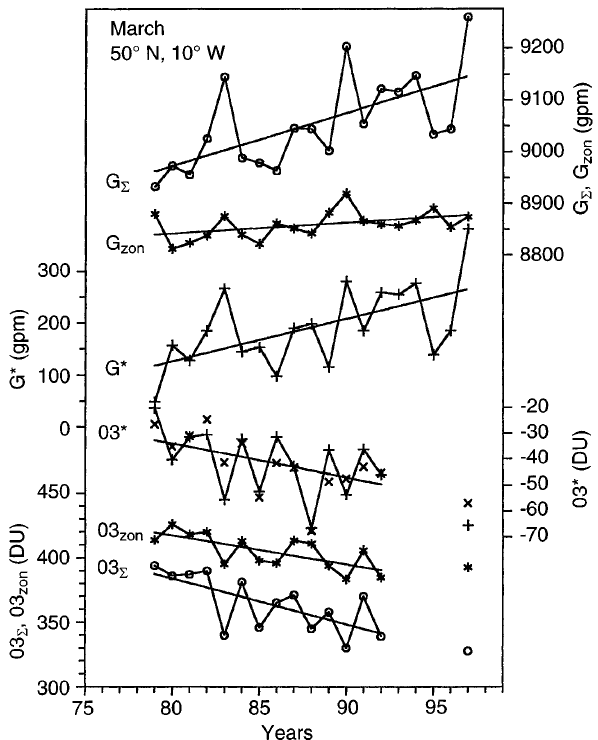
Fig. 4. Monthly mean values of March from 1979–97 for ozone (O3) (TOMS-measurements) and the geopotential ( G ) of the 300 hPa-level (NCEP-data). The values are given in zonal mean values (zon), the disturbances (*) and the sum of both ( S ) at 50 (cid:176) N 10 (cid:176) W. O3*: + original values; x influence of geopotential interannual variability eliminated